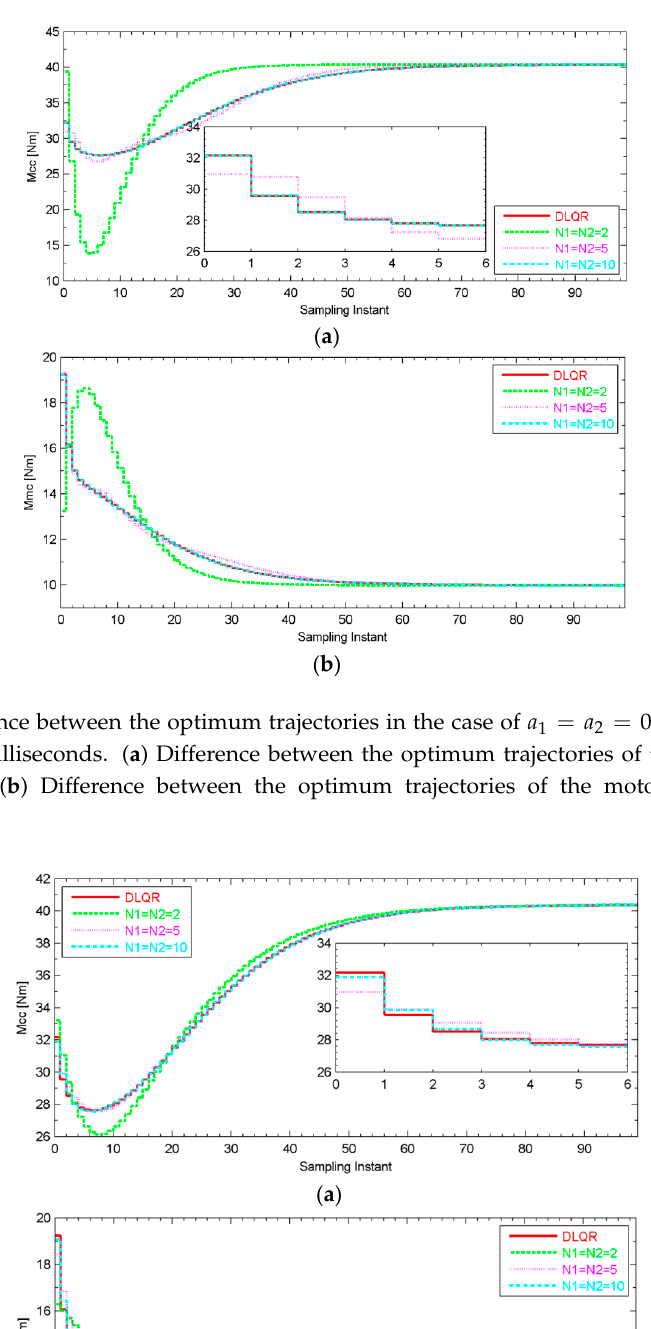
( a ) ( b ) Figure 8. Difference between the optimum trajectories in the case of (cid:1853) (cid:2869) (cid:3404) (cid:1853) (cid:2870) (cid:3404) 0.99 . The sampling interval is ten milliseconds. ( a ) Difference between the optimum trajectories of the clutch torque command (cid:1839) (cid:3030)(cid:3030) ; ( b ) Difference between the optimum trajectories of the motor output torque command (cid:1839) (cid:3040)(cid:3030) .